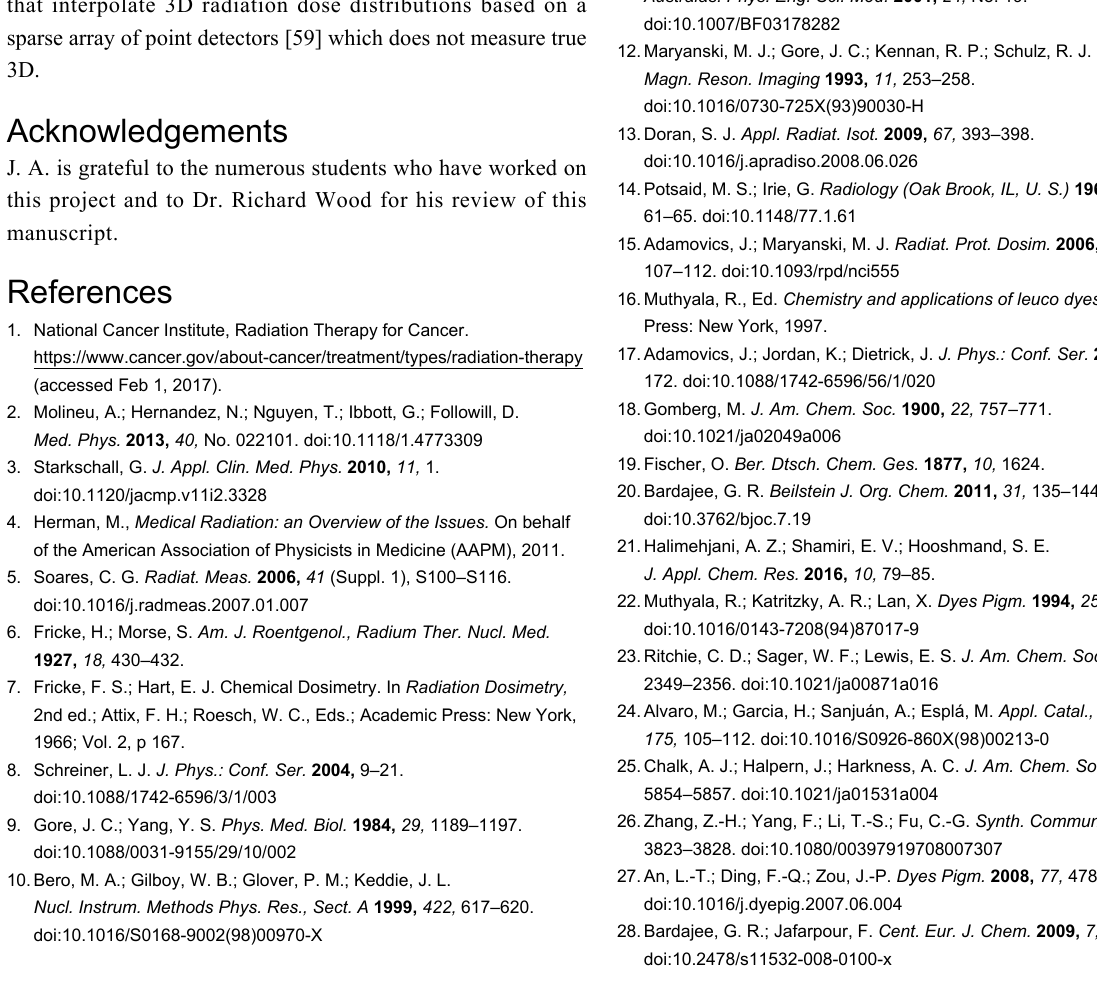
availability of alternative semi-3D radiation measuring systems that interpolate 3D radiation dose distributions based on a sparse array of point detectors [59] which does not measure true